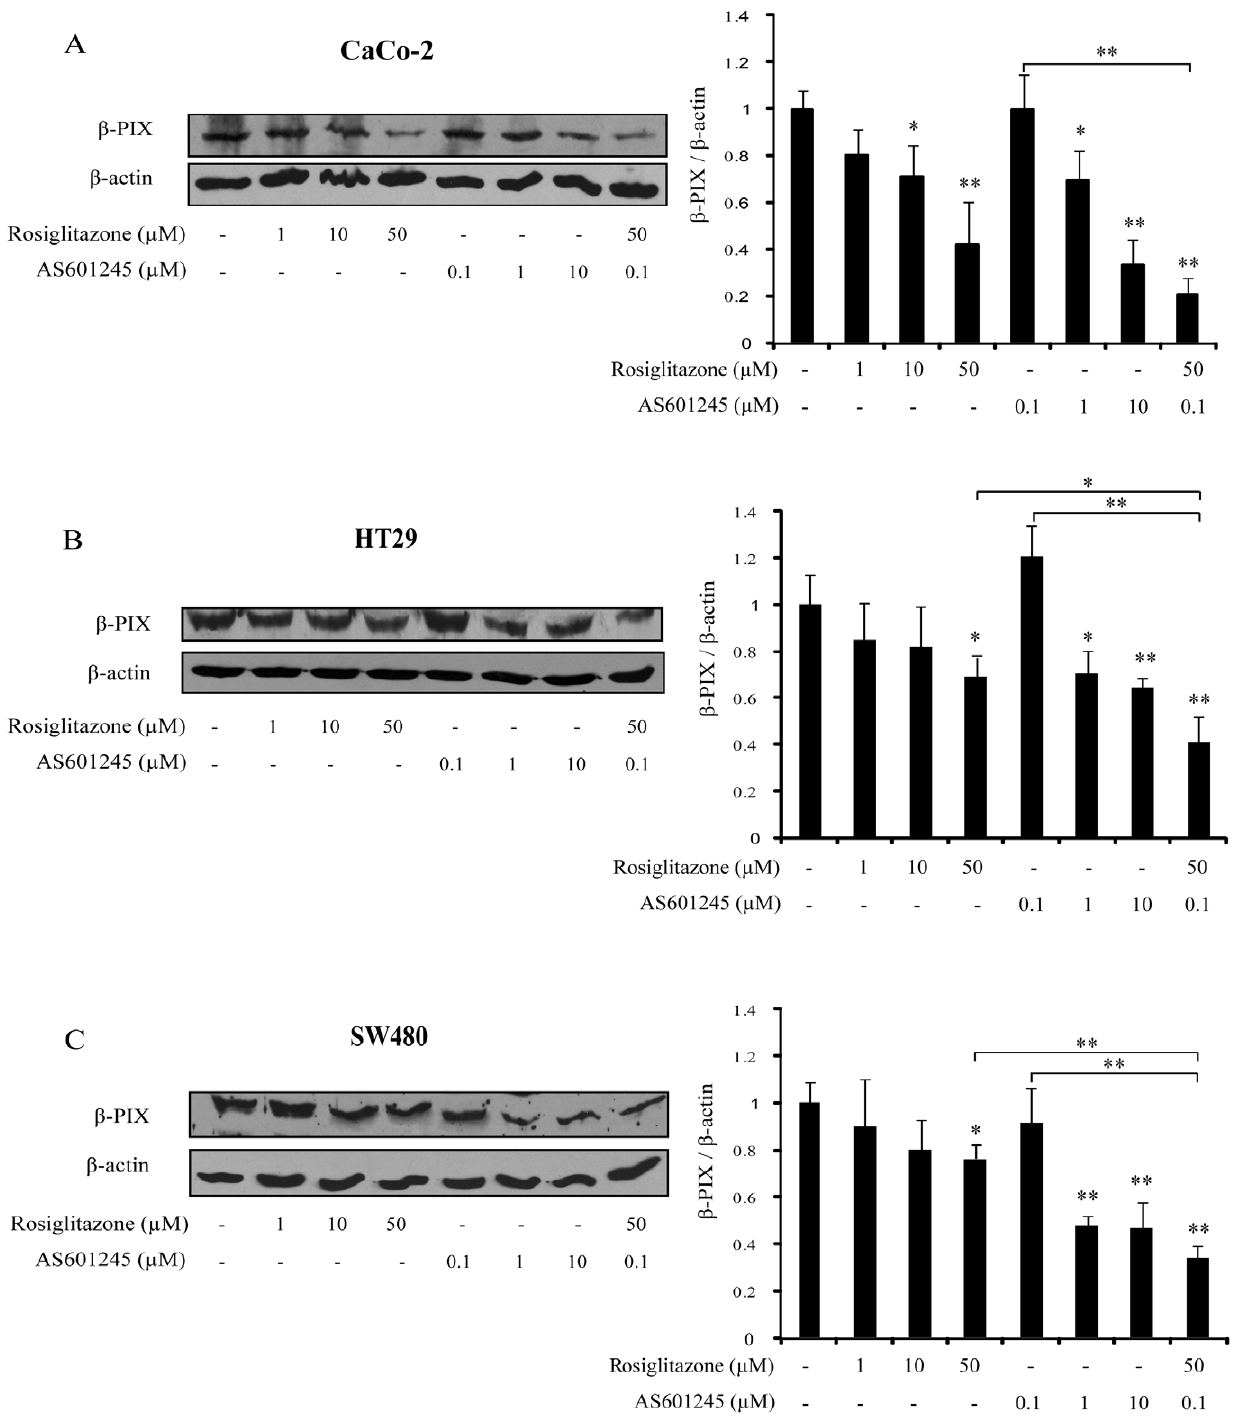
Figure 6. b -PIX protein expression. Western blot analysis of b -PIX expression in CaCo-2, HT29 and SW480 cells, treated for 24 hours with different concentrations of rosiglitazone (1, 10, 50 m M), AS601245 (0.1, 1, 10) and combined treatment with 50 m M rosiglitazone and 0.1 m M AS601245. Equal protein loading was confirmed by exposure of the membranes to the anti- b -actin antibody. Quantification of protein products (on the right) was performed by densitometric scanning. Data are normalized using the b -actin signal and are indicated as means 6 SD from three independent experiments. (A) Western blot analysis of CaCo-2 cells and relative densitometric values. (B) Western blot analysis of HT29 cells and relative densitometric values. (C) Western blot analysis of SW480 cells and relative densitometric values. Variance analysis: * p , 0.05, ** p , 0.01 vs control or rosiglitazone treated cells.